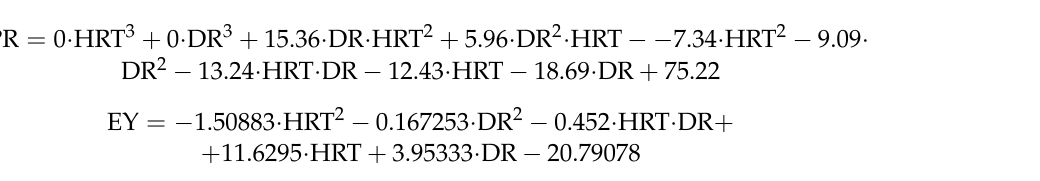
Figure 9. Ramp plot for desirability analysis: maximization of EPR and EY with variables DR and HRT. The mathematical models for the EPR and EY were given in Equations (2) and (3),